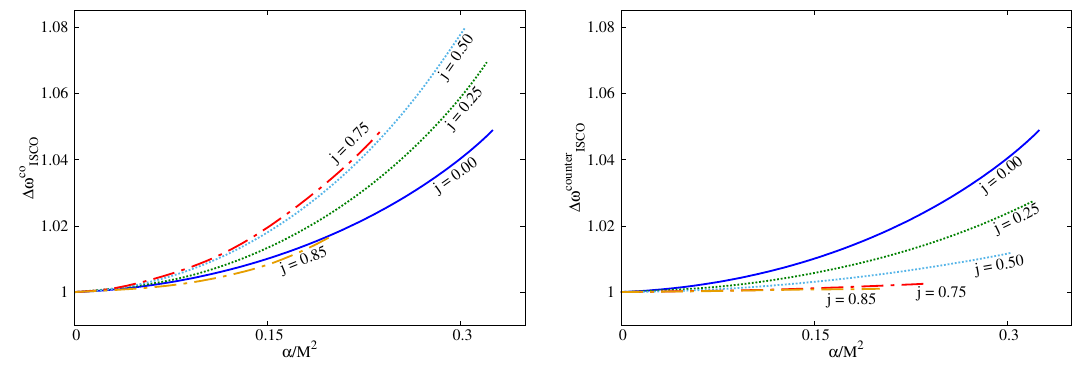
Figure 6 . Ratio between the angular frequency at the ISCO between EsGB BHs and Kerr BHs for co-rotating orbits (left panel) and counter-rotating orbits (right